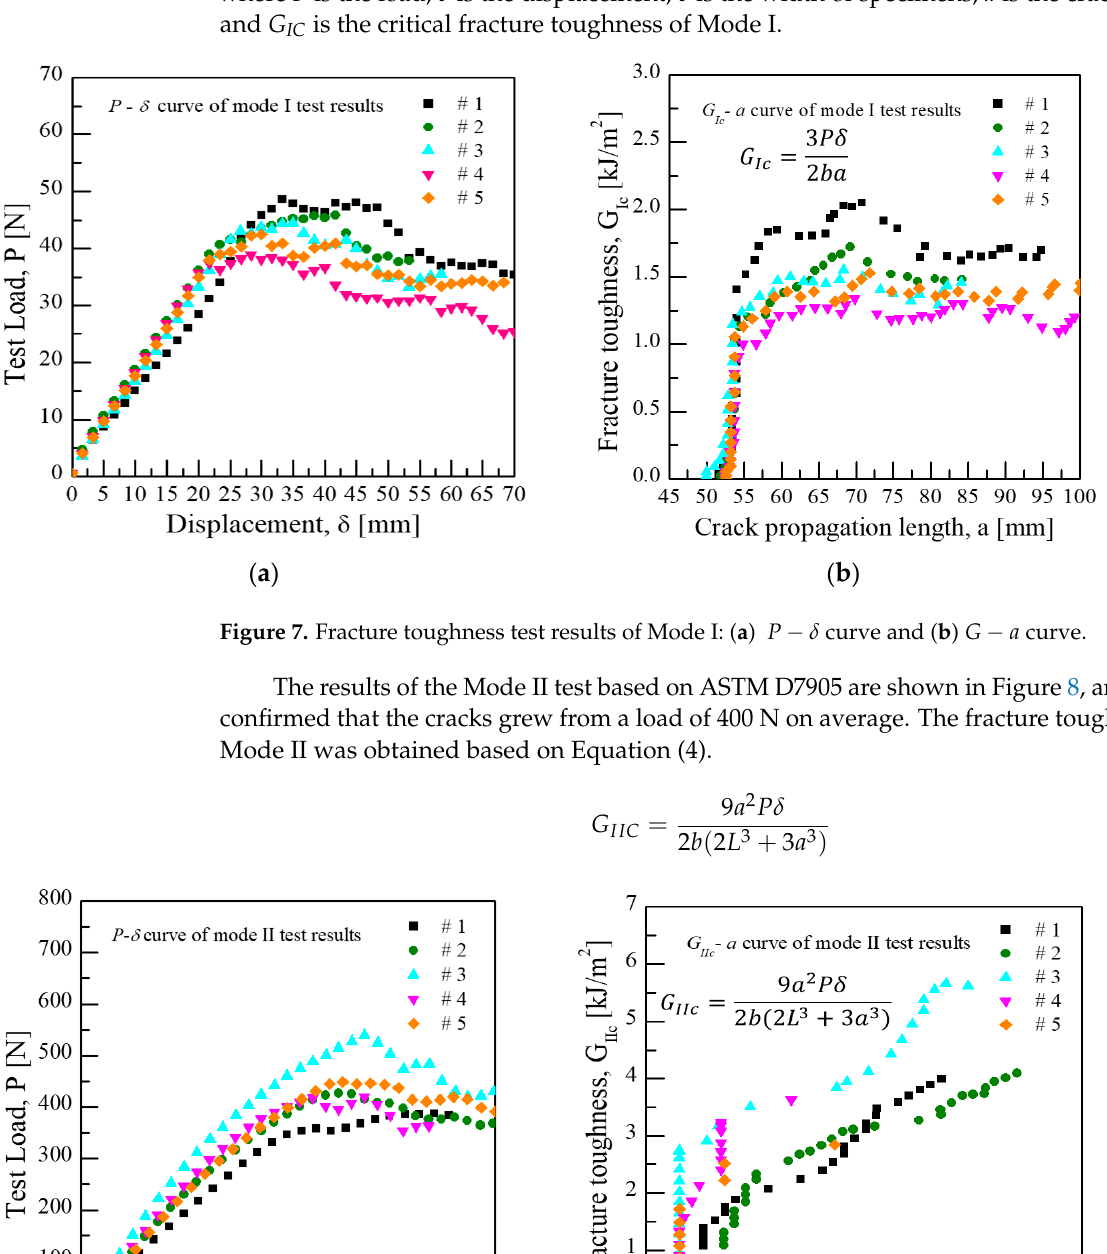
Figure 7. Fracture toughness test results of Mode I: ( a ) 𝑃 − 𝛿 curve and ( b ) 𝐺 − 𝑎 curve.